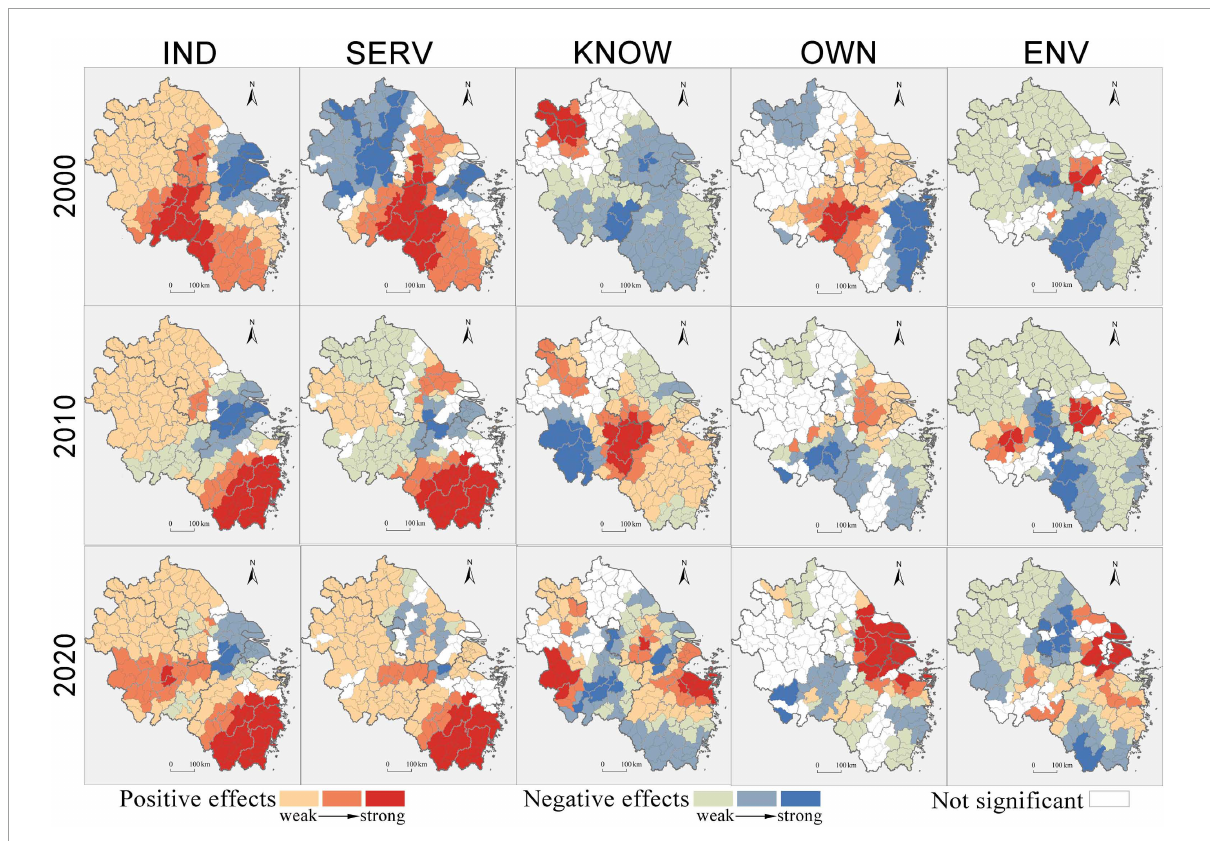
FIGURE7 GWR estimated coefficients for independent variables in 2000, 2010, and 2020 (the estimated coefficients with p -values less than 0.1 are considered